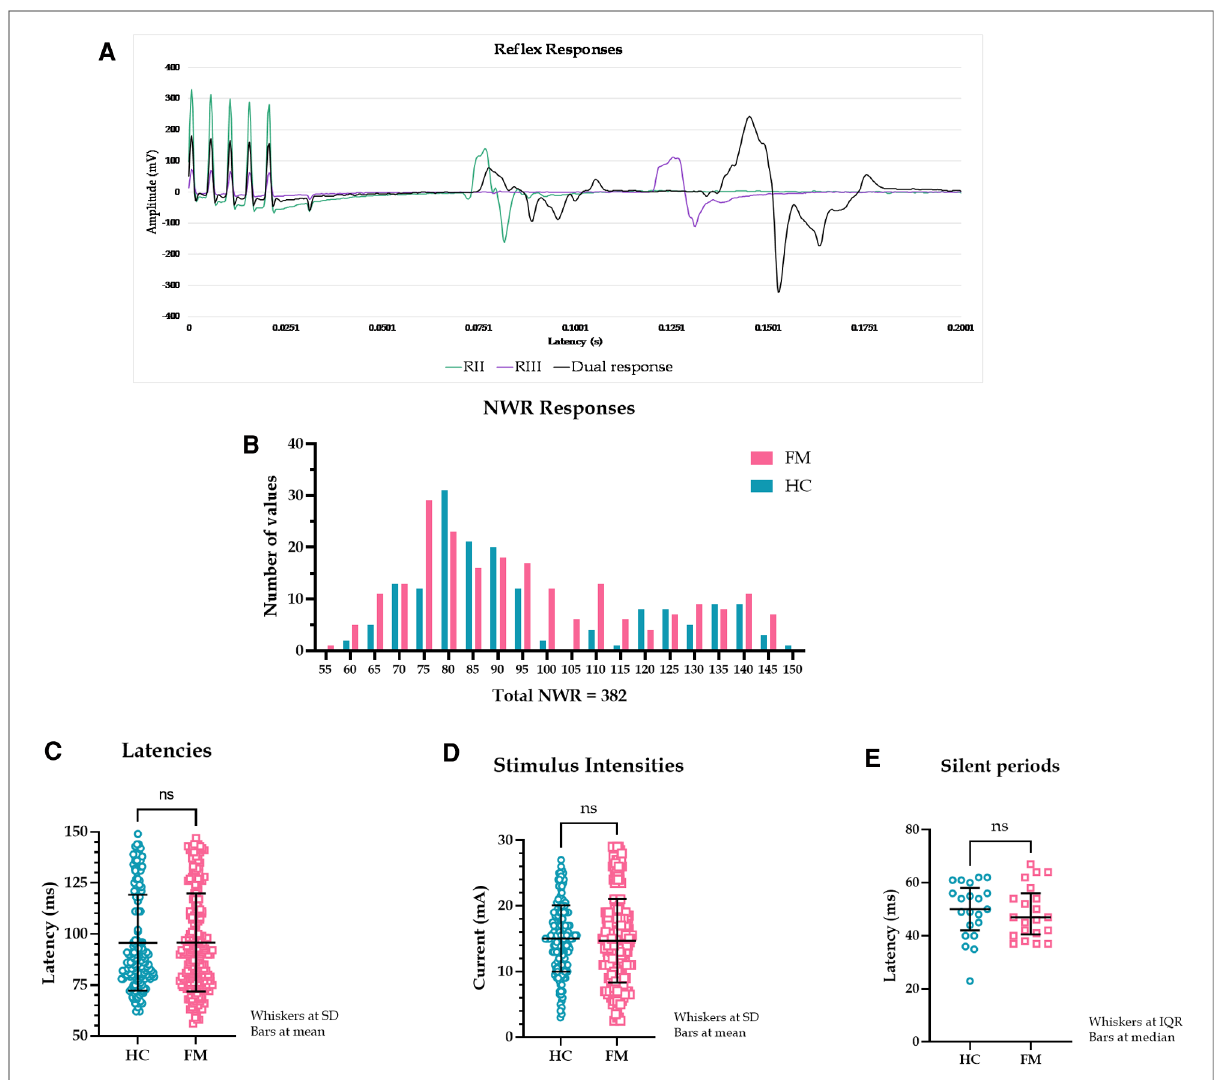
FIGURE 1 ( A ). Examples of re fl ex recordings with RII, RIII, and dual responses superimposed. The fi ve peaks at the beginning of the graph represent the electrical stimulus (5 square pulses). ( B ). Latency spread of painful NWR responses. Healthy controls (HC) had a bimodal distribution while fi bromyalgia patients (FM) had a more even distribution throughout the time analysis window. The y-axis shows the number of NWR responses, and the x-axis shows re fl ex latencies. ( C ). Latencies of all NWR responses from HC and FM. Latencies did not differ between the two groups (HC: 95.7±23.5 ms, FM: 95.7±24.0 ms, t (380)=0.043, p =0.965, 95% CI [-4.722, 4.936], Hedges ’ g=0.004, CLES=50.1%). ( D ). Stimulus intensities of all NWR responses in HC and FM. Stimulus intensities were not different between HC and FM (HC: 15.0±5.0 mA, FM: 14.7±6.4 mA, t (380)= 0.568, p =0.570, 95% CI [-1.524,.840], Hedges ’ g=0.059, CLES=51.7%) but were signi fi cantly higher for eliciting a painful re fl ex than just pain regardless of subject type (at least p <0.05, Wilcoxon test). ( E ). Duration of silent EMG period intervening a dual re fl ex response occasionally seen. No statistical difference was found in the duration of the silent period between HC and FM (HC: 50.0 (16.0) ms, FM: 47.0 (15.6) ms, U =203, p =0.667,